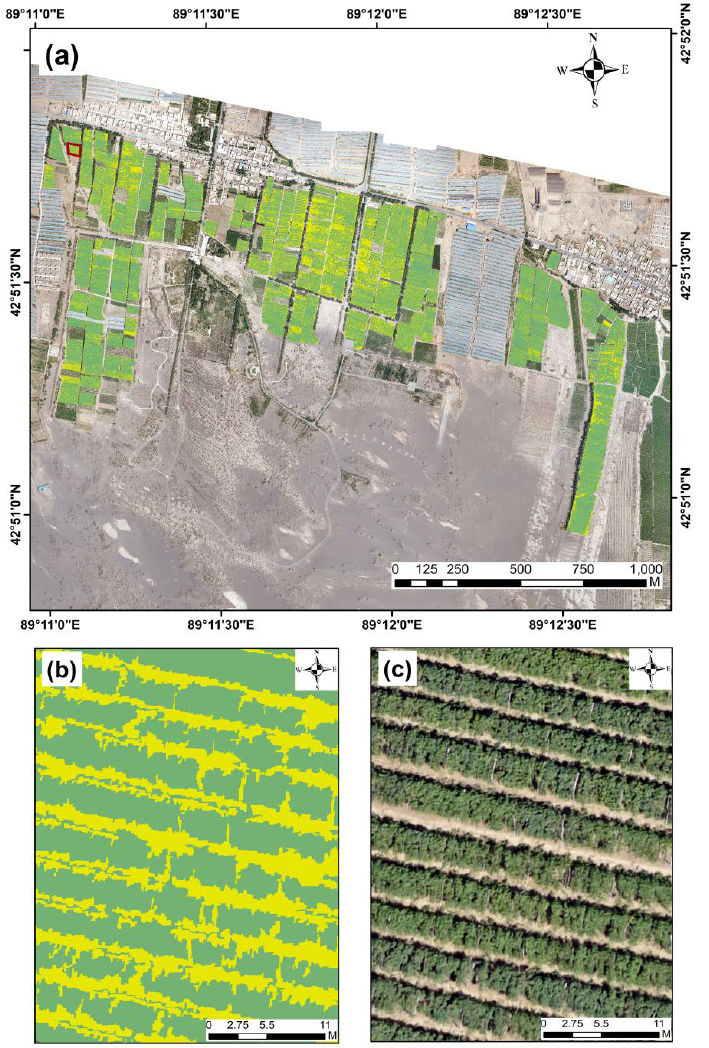
Figure 2. Distribution of vegetation fraction and soil and shadow: ( a ) shows the whole field; ( b ) and ( c ) show a small area of the field in the red box.